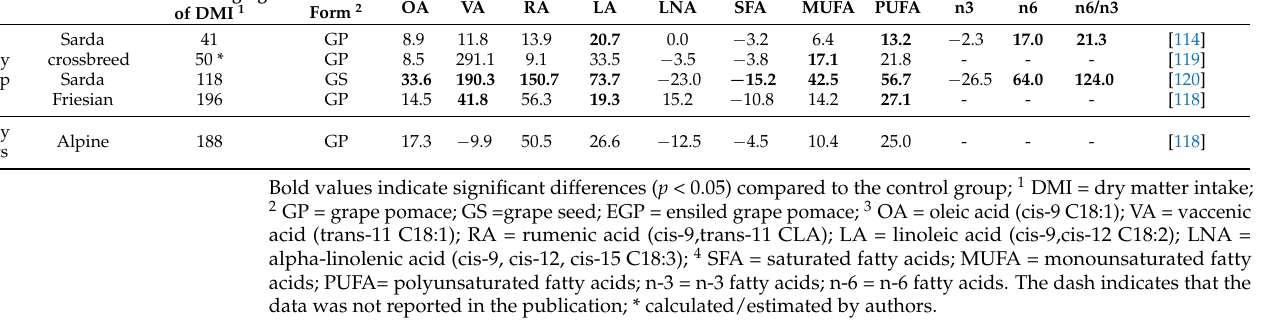
Table 4. Effect of pomegranate by-products included in dairy ruminants’ diets on milk yield, fat%, protein%, and the fat-to-protein ratio. Data are reported as the proportional difference between the treatment group, at the respective level of inclusion, and the control group.